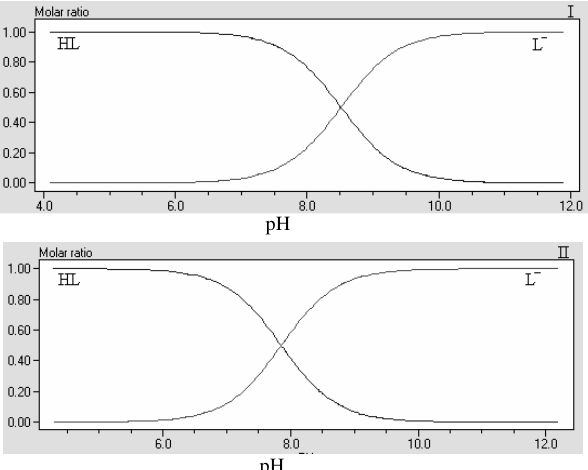
as a function of pH for the spectral data of F